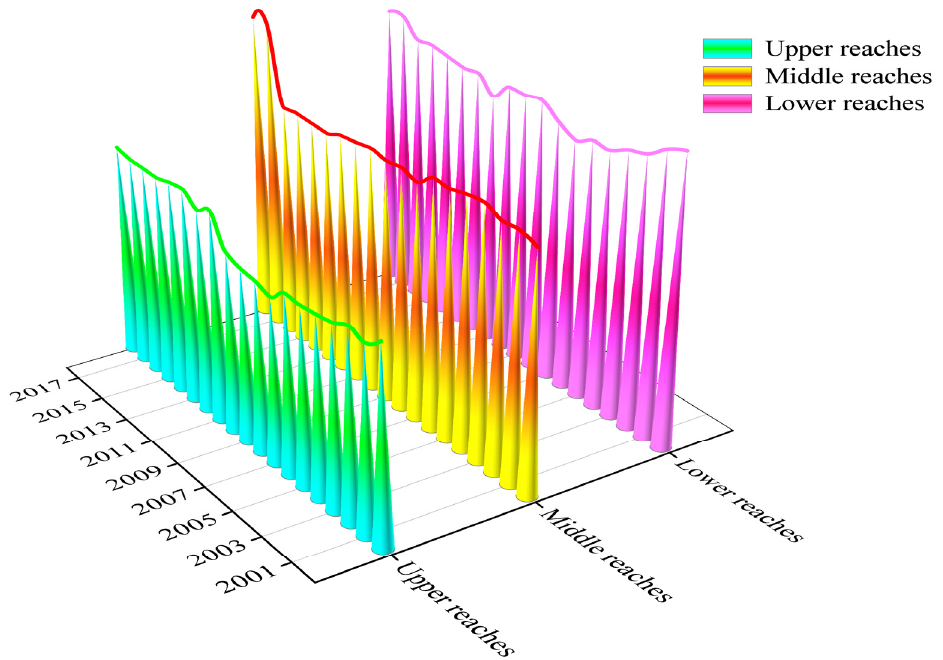
Figure 8. Evolution of intra-regional gap of net carbon sequestration of grain food crops in the YREB. The values of Gini coefficient in the middle reaches are between 0.235 and 0.309, which indicates the distribution of net carbon sequestration changed from the “comparative average” state to the “relatively reasonable” state. The regional distribution difference of the middle reaches is between the upper reaches and lower reaches, and the change trend shows a “decline-up” state. In 2005, the Gini coefficient reached the minimum, so the regional difference of the distribution of net carbon sequestration in 2005 was the